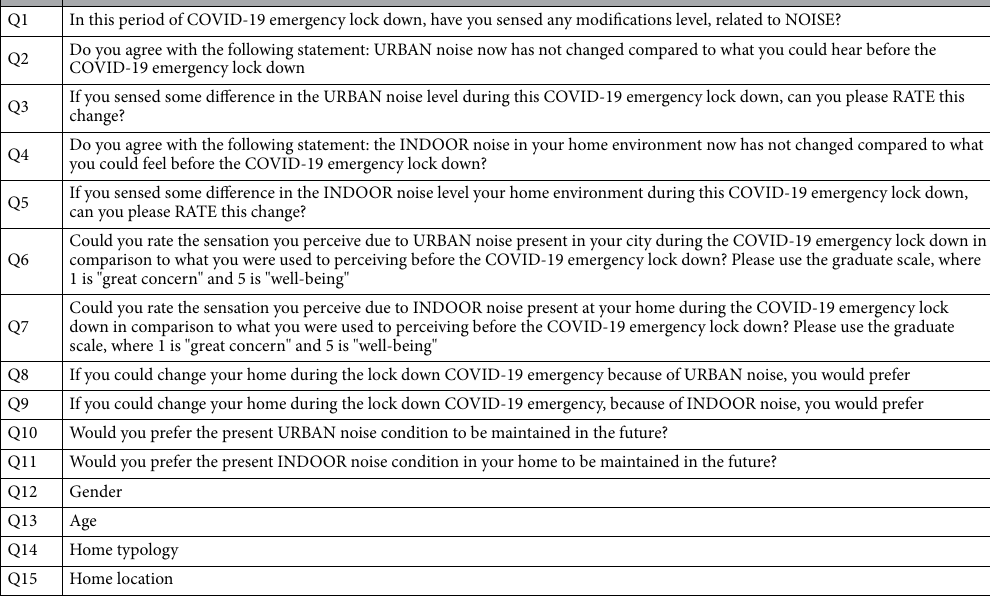
Table 1. Proposed survey.